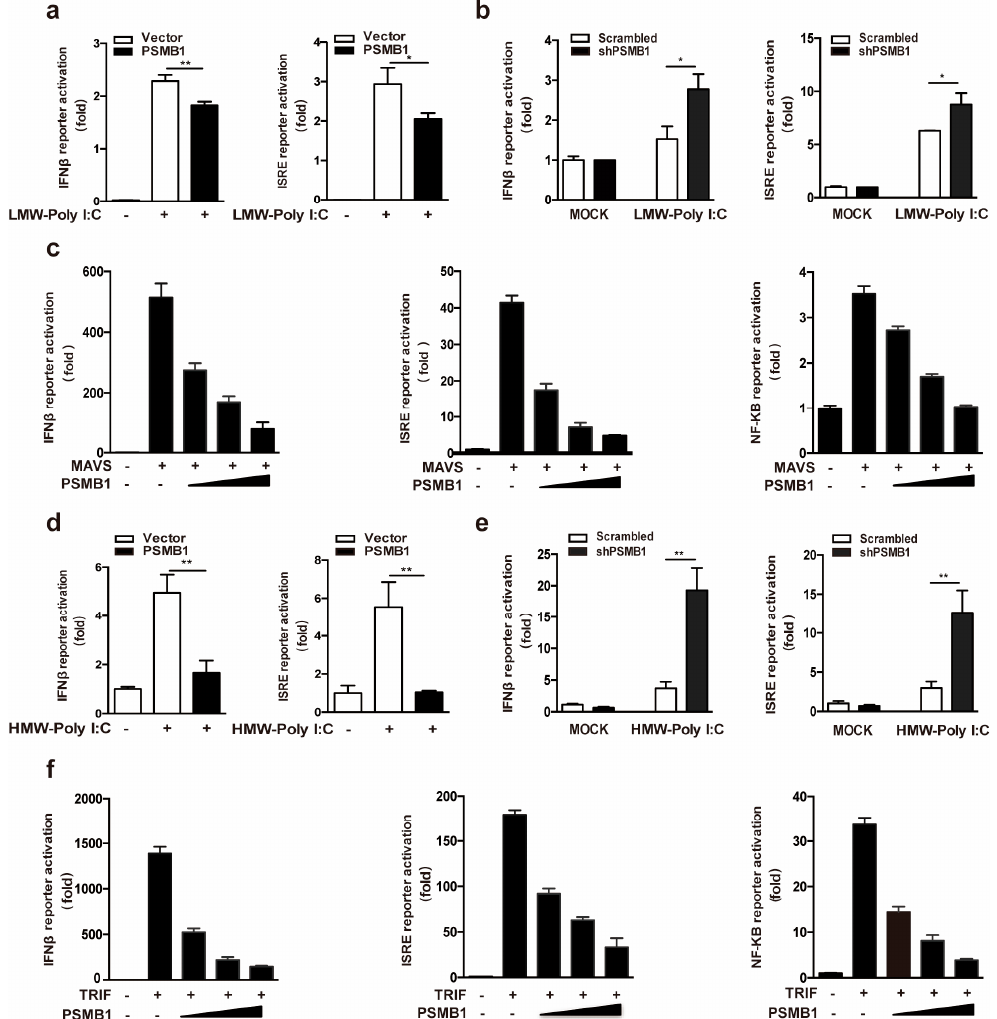
Figure 3. PSMB1 Inhibits RIG-I-like Receptor (RLR) and Toll-like receptor 3 (TLR3)